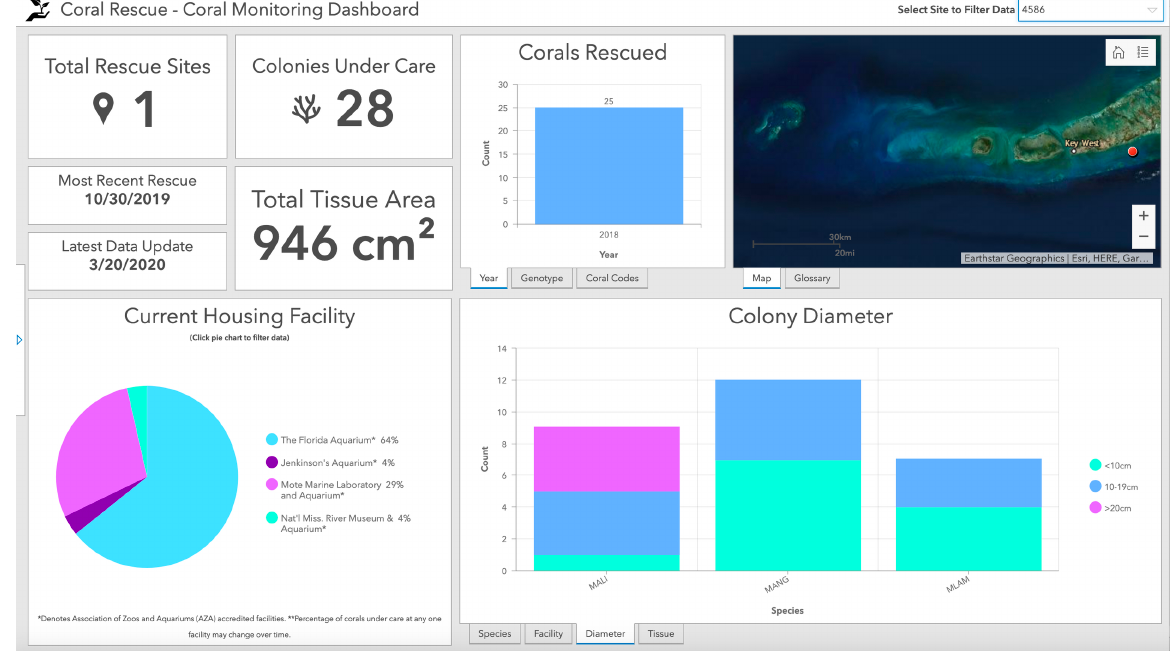
Figure 6: Coral Monitoring Dashboard, search site to filter data to site 4586. Screenshot captured August 1, 2020. Source: FWC Fish and Wildlife Research